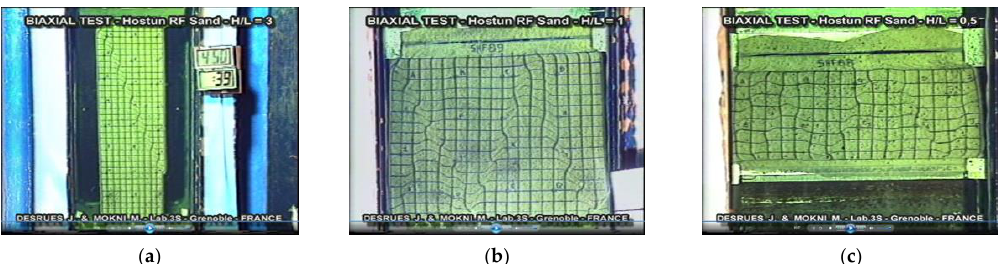
Figure 13. The influence of Hostun RF sand sample dimensions in the biaxial compression test on the bifurcation phenomenon and the range of disturbance zone, on the example of images recorded by stereophotogrammetry: ( a ) sample of dimensions H/D = 3; ( b ) sample of dimensions H/D = 1; ( c ) sample of dimensions H/D = 0,5; (source: video film of Desrues J. and Mokni M. 2000; based on [109], available via 2021 Desrues’ permission).